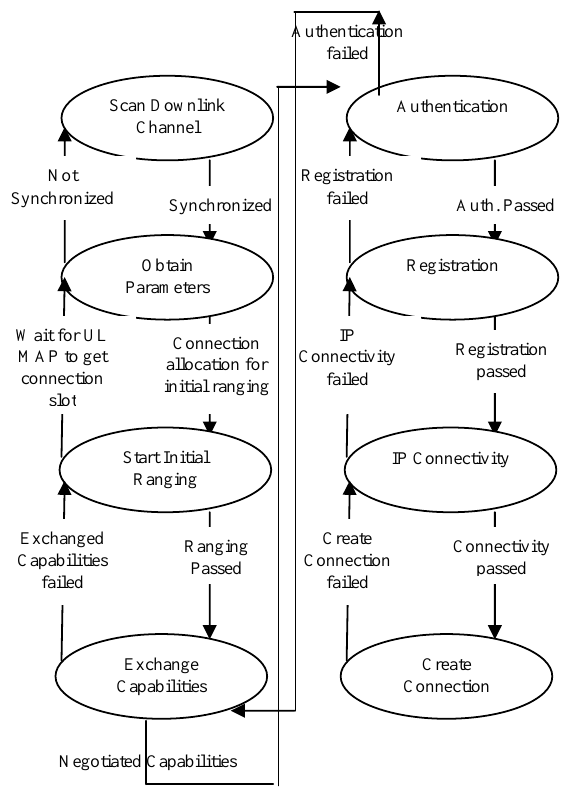
Figure 5. MAC Operation - Network Entry